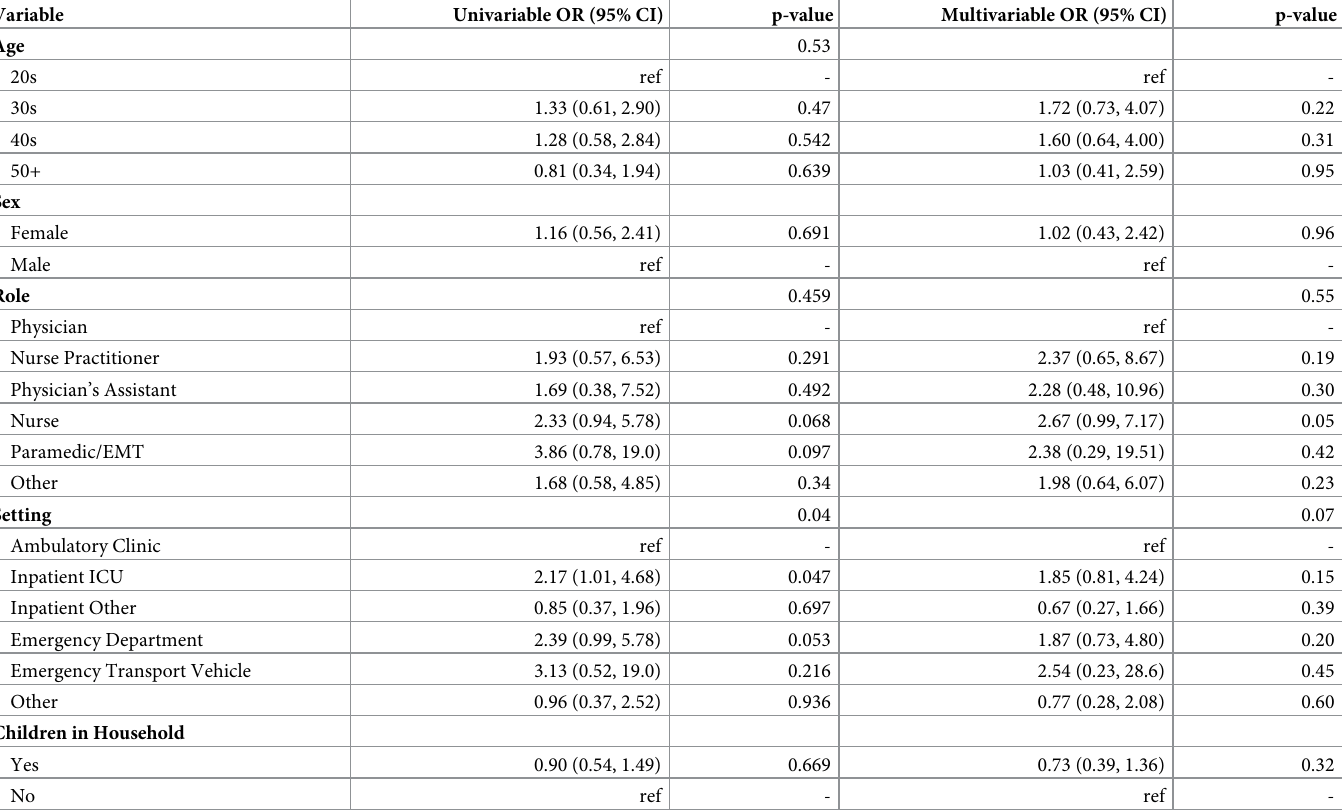
Table 2. Association of SARS-CoV-2 infection with participant characteristics using logistic regression among subgroup of participants that completed a nasopha- ryngeal swab and were not vaccinated for COVID-19 at time of serology testing (N =